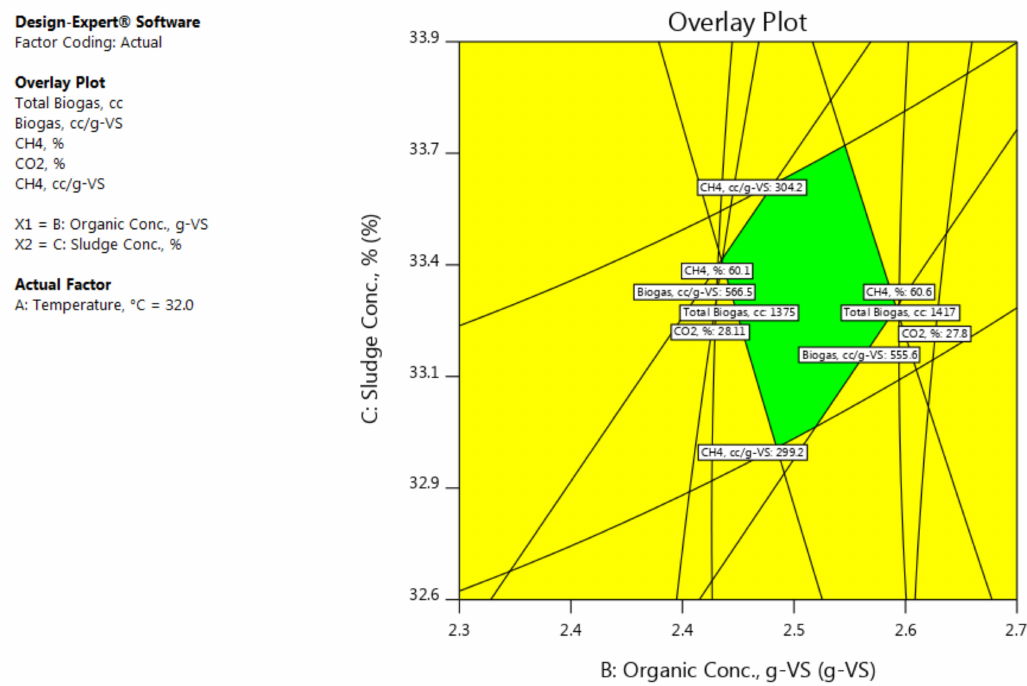
Figure 12. An overlay plot illustrating the optimum biogas based on the 2nd criterion (cost).